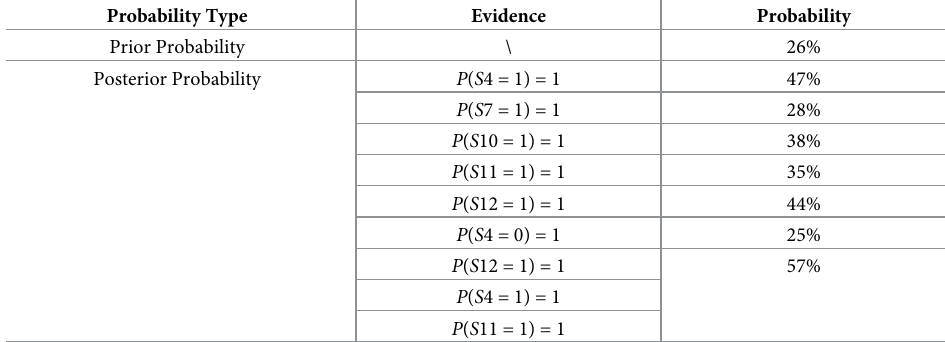
Table 10. Probability of hidden cost of prefabricated buildings.